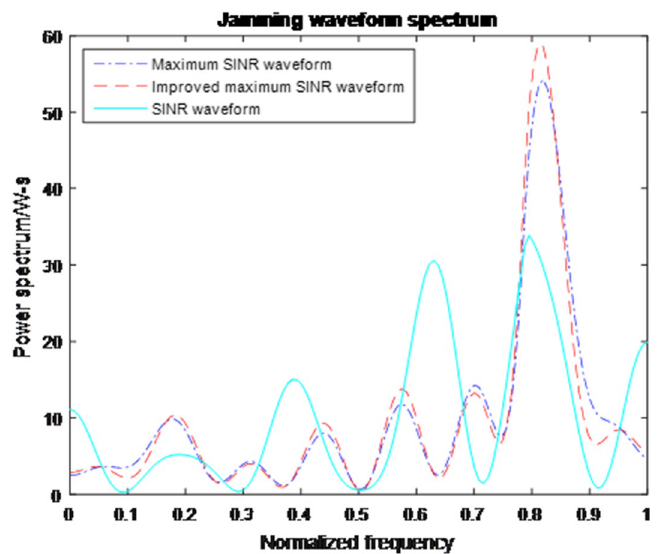
Fig. 11 Jamming waveform spectrum of jammer with minmax